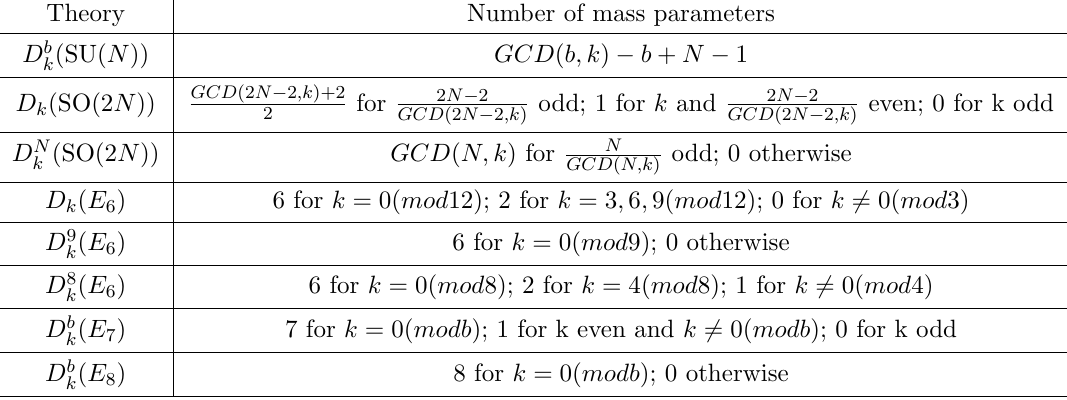
( J ) theories excluding the J k